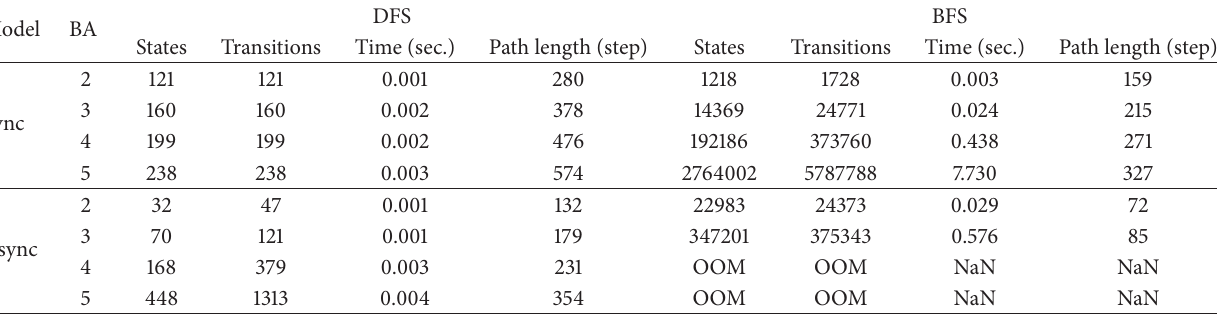
Table 4: Experimental results of property p 1.